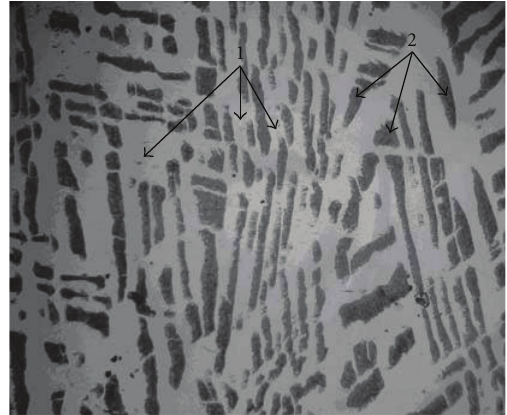
Figure 4: Co8 optical micrograph ( × 200) showing the matrix (1) and pearlite